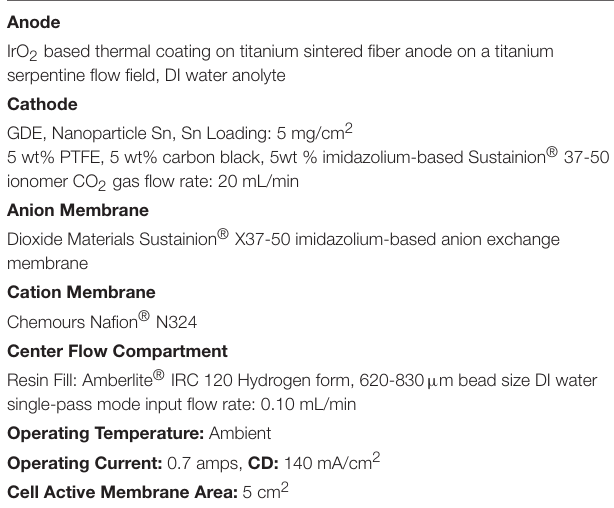
TABLE 2 | Formic acid cell 142h extended run electrolyzer configuration.